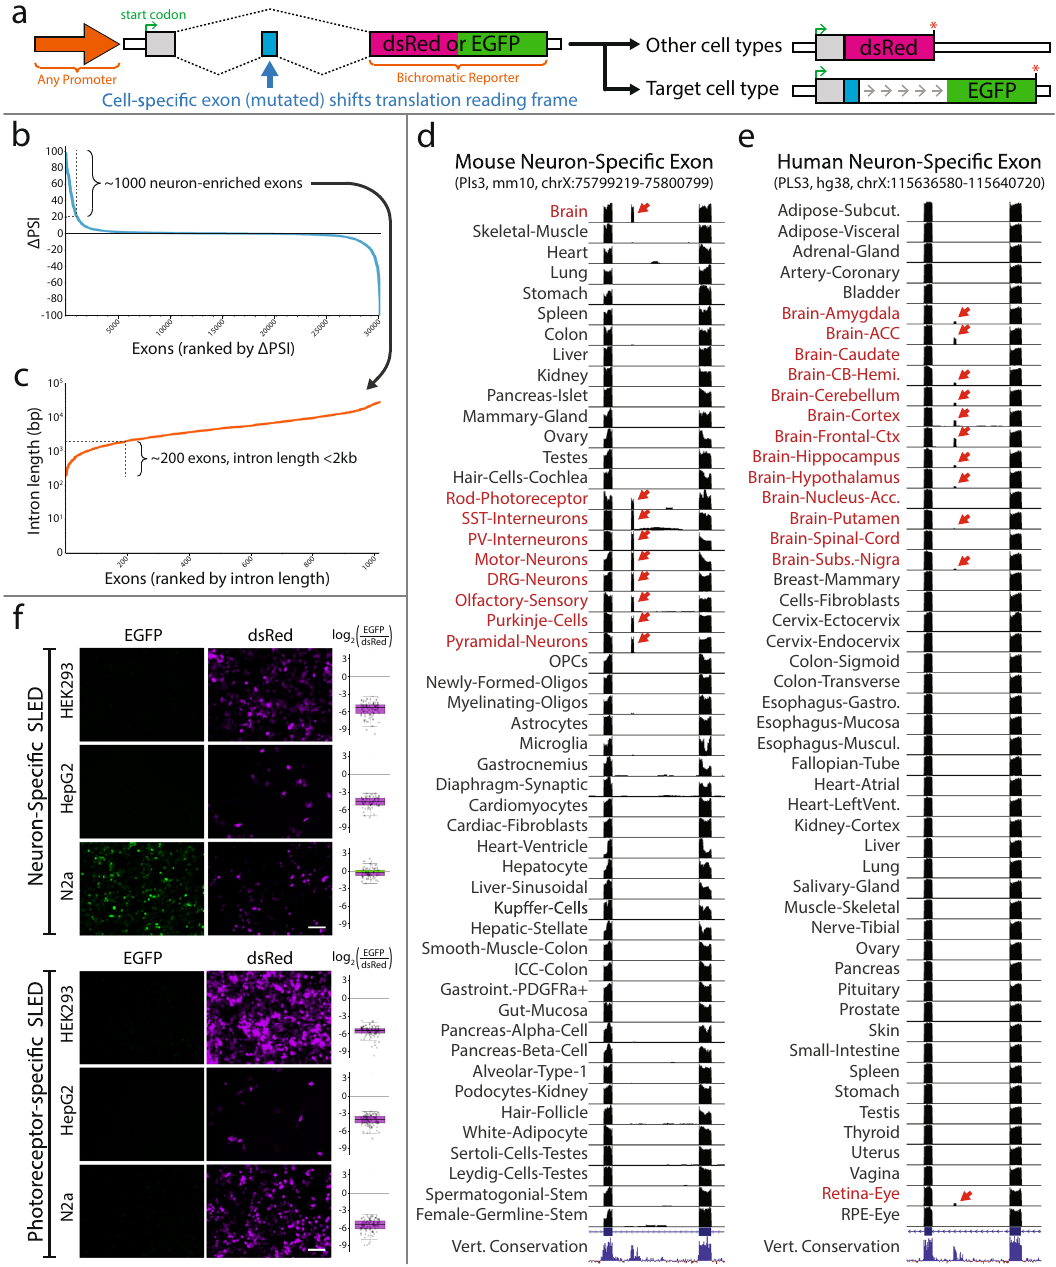
Fig. 1 | Identi fi cation of cell-speci fi c exons and SLED vector construction. a Diagramatic sketch of SLED vector design strategy. SLED is compatible with any promoter. A frameshifting mutation is introduced into a cell-speci fi c alternative exon to create two potential translational reading frames from an upstream start codon. In mostSLEDvectors, exon skipping willproducea red fl uorescent protein while exon inclusion will shift the reading frame to produce a green fl uorescent protein. b Ranking all neuron-enriched exons by the percent spliced-in (PSI) dif- ference between neurons and other cell types. Exons were identi fi ed from mouse RNA-Seq datasets analyzed with the ASCOT pipeline 29 . Approximately 1000 neuron-enriched exons have a Δ PSI greater than 20. c Among these top 1000 exons, approximately 200 candidates reside in introns <2kb in length. d , e UCSC genomebrowserviewsoftheneuron-speci fi cexonin Pls3 thatisusedinSLED.NPL.